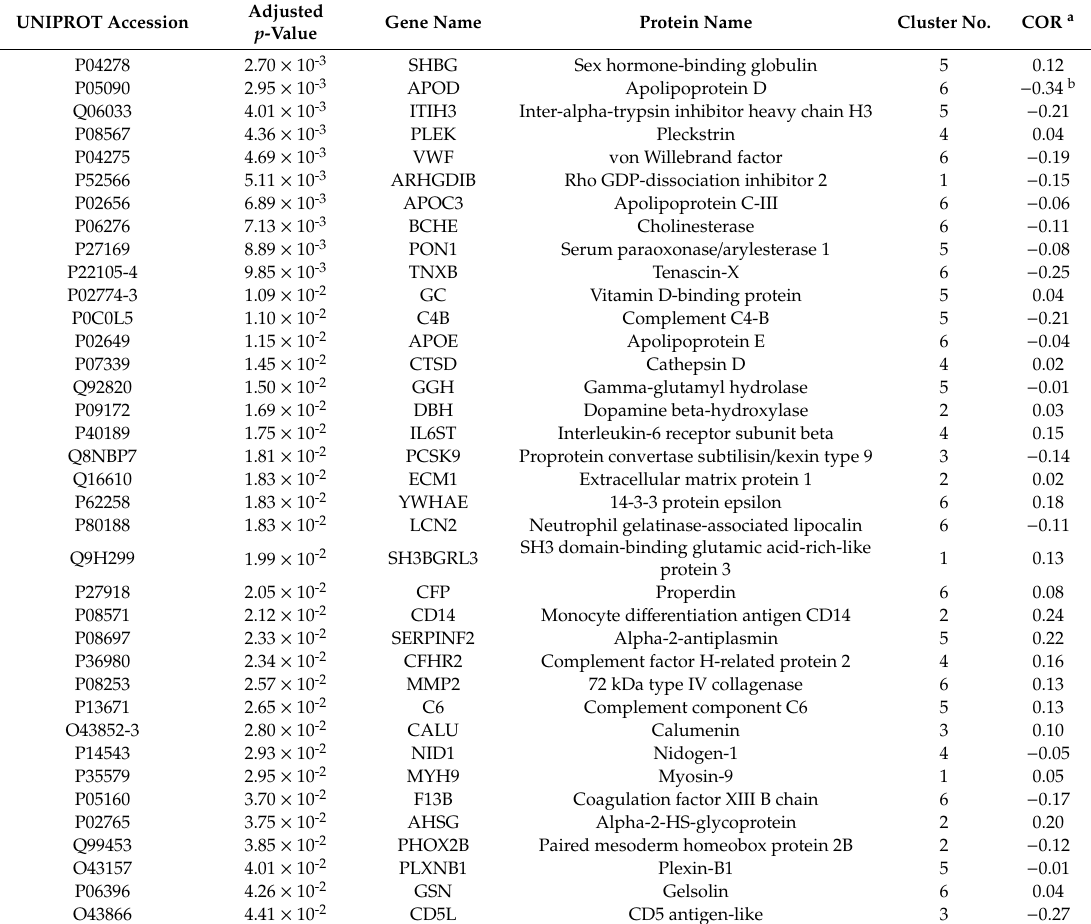
Table 2. 37 di ff erentially abundant proteins corresponding to response / time